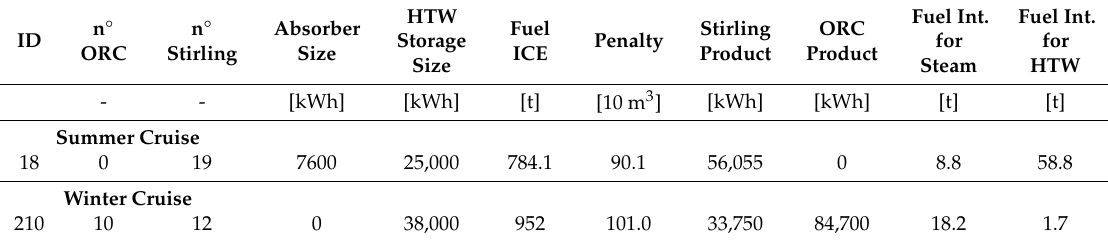
Table 6. Optimal compromise solutions identified on the Pareto fronts (Figures 11 and 12).